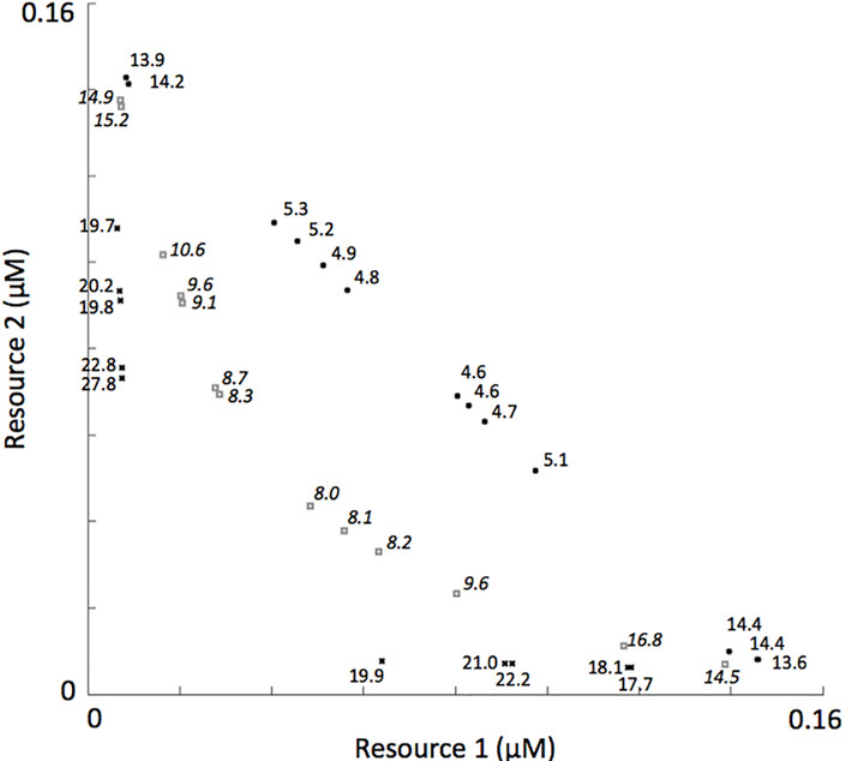
Fig 10. Representative R * species distributions from self-organized assemblages where the initial species pools had the lowest (filled circles), intermediate (open squares) and highest (crosses) levels of complementarity. The numbers associated with each marker is the time-averaged biomass of that species when in